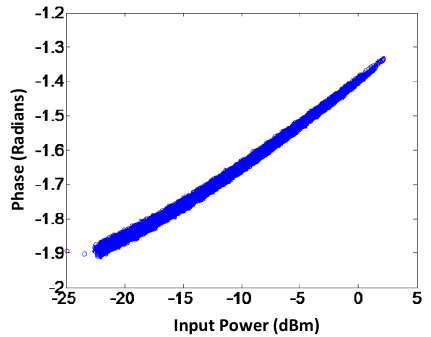
Figure 3. Phase response of the VGA.